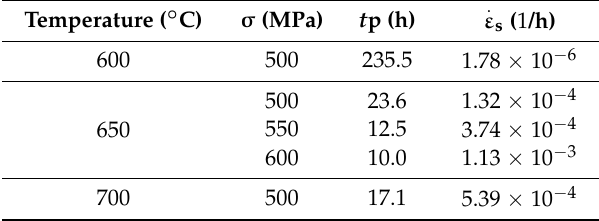
Table 3. Creep data of the Inconel 625.